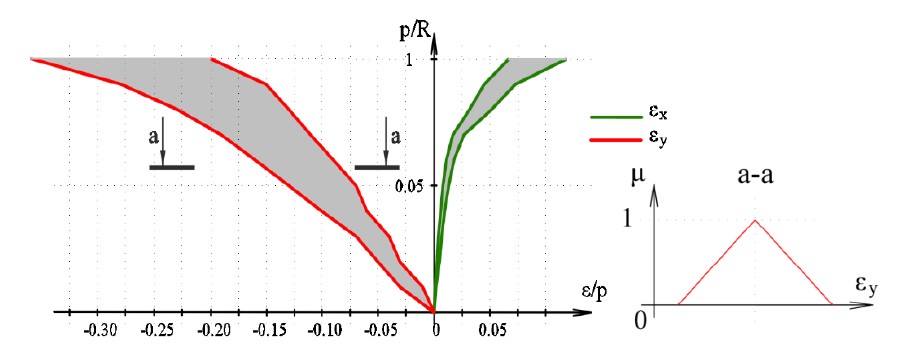
Fig. 3 . The stress-strain relationship is under uniaxial